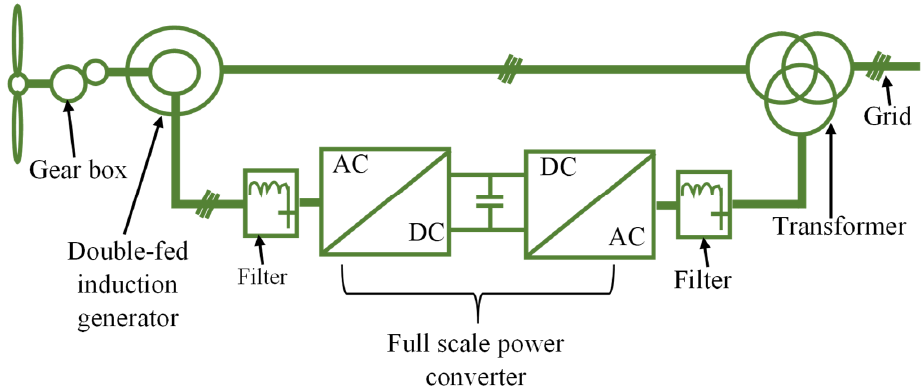
Figure 5. Wind turbine with DFIG.